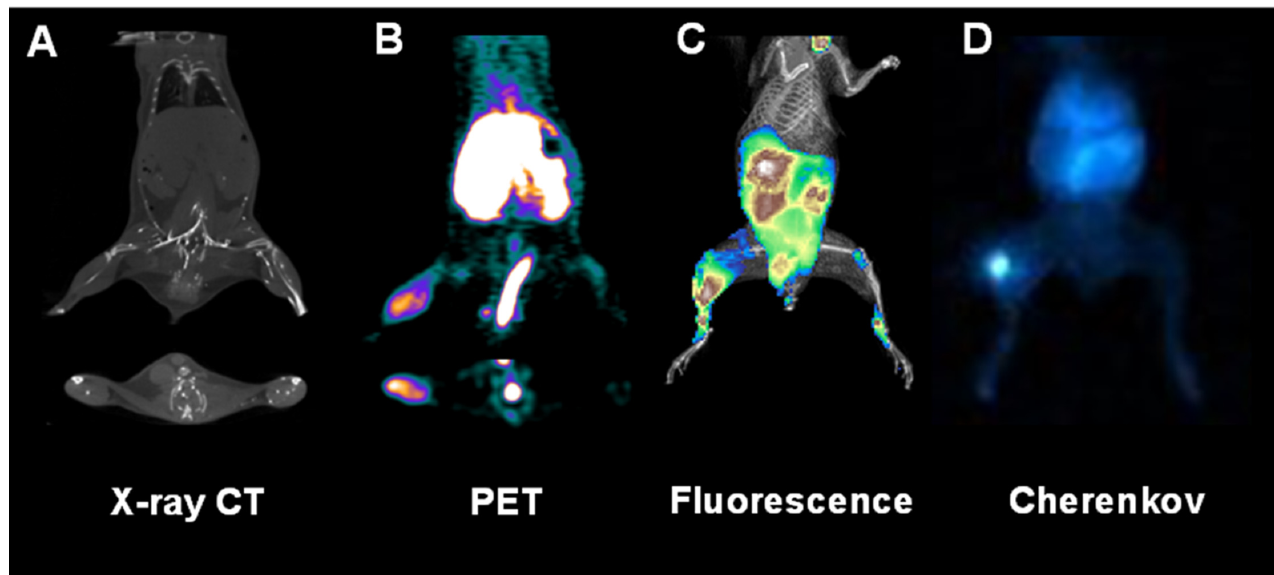
Figure 1. Multimodal multifunctional nanoparticles allow the in vivo imaging of anatomy, physiology, and molecular events at various spatiotemporal scales. Shown here are representative images of a mouse subjected to surgical ligation of the right femoral artery to induce hindlimb ischemia followed by the inflammatory response, which is assessed with a receptor for an advanced glycation end product (RAGE)-targeted nanoparticle-based multimodal agent labeled with both fluorophore (rhodamine) and radioisotope ( 64 Cu). The anatomy was assessed with X-ray computed tomography (CT) imaging ( A ). In contrast, molecular proinflammatory events were quantitatively assessed in vivo with positron emission tomographic (PET) imaging ( B ), whole-body fluorescence ( C ), and Cherenkov luminescence ( D ).